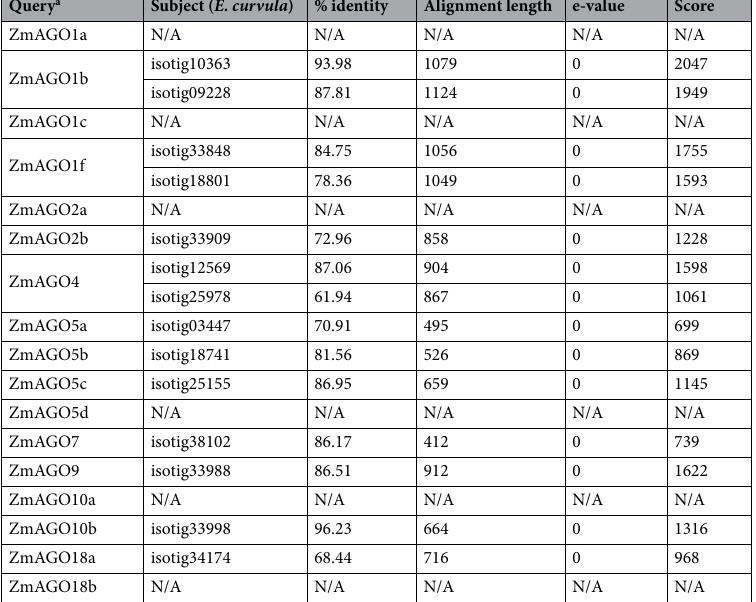
Table 1. Members of the ARGONAUTE family queried against the Eragrostis curvula protein prediction databases. a Query names as described by 18 . They renamed ZmAGO104 to ZmAGO9; therefore, the isotig33988 is the ortholog of ZmAGO104.